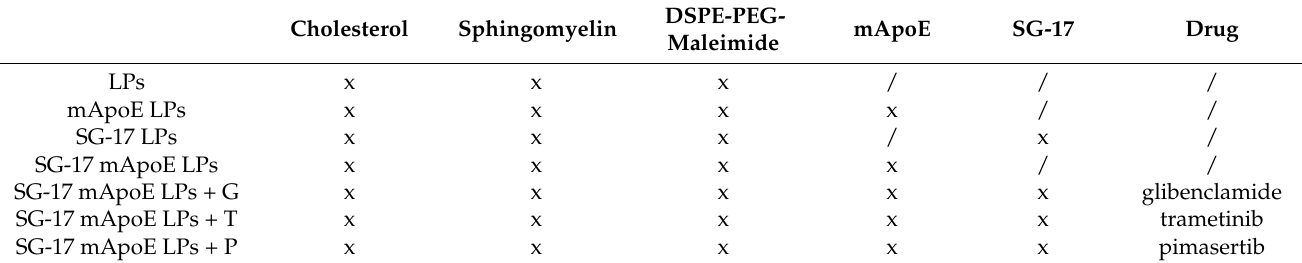
Table 1. List of different LP formulations that were analyzed using Raman Spectroscopy. x is indicated when the component was included in the formulation, / is indicated when the component is not included in the formulation. DSPE-PEG- mApoE Cholesterol Sphingomyelin Maleimide